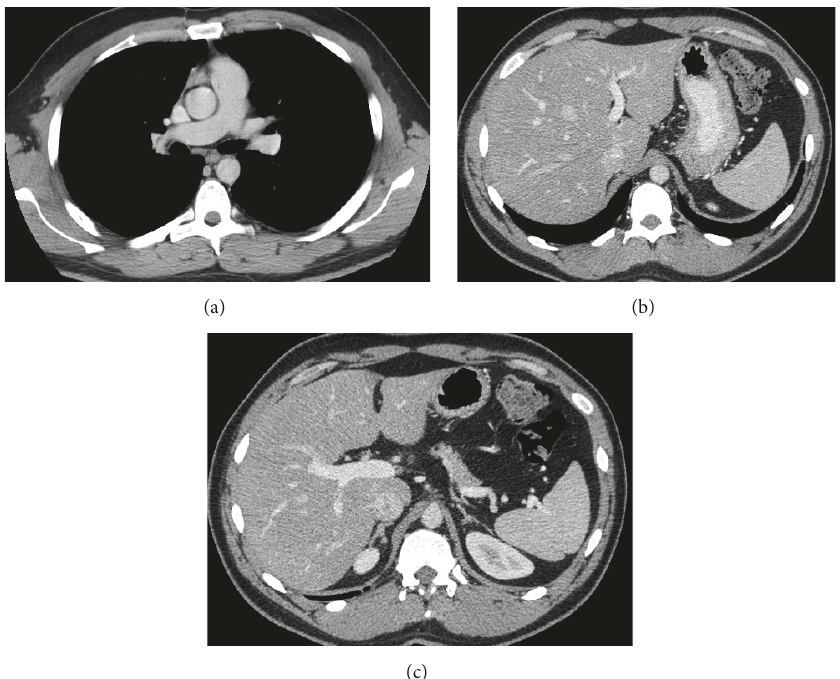
Figure 3: Contrast-enhanced multislice CT of the chest (a) on mediastinal window showed no thoracic lymphadenopathy. Multislice abdominopelvic CT scans (b and c) with intravenous contrast administration showed no significant findings, excluding focal liver or splenic